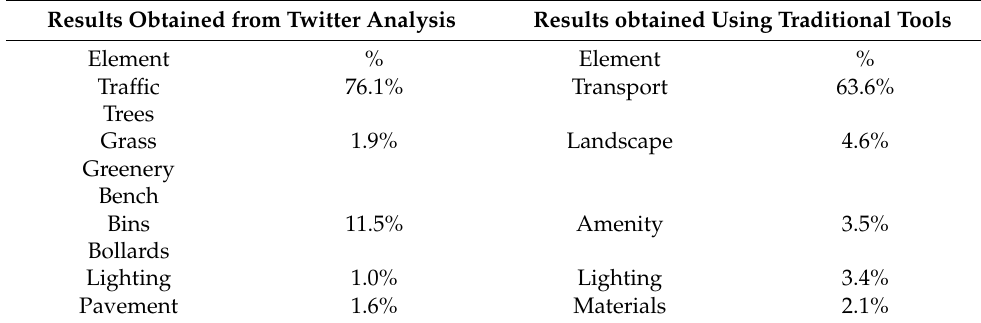
Table 6. Comparison of the results obtained from Twitter and by using traditional tools in relation to an individual